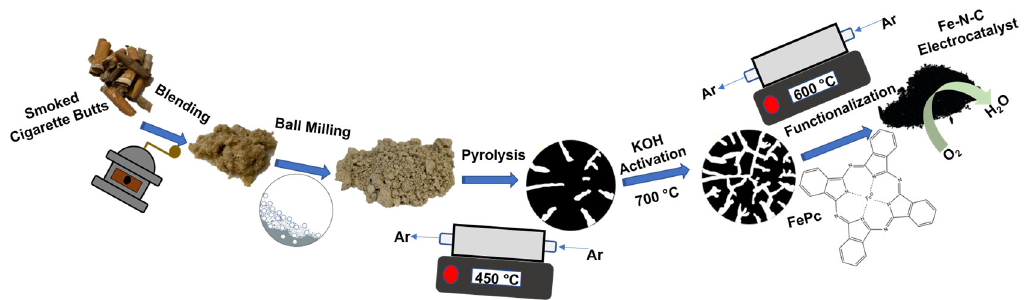
Figure 1. The synthesis scheme of the ORR electrocatalysts prepared in this